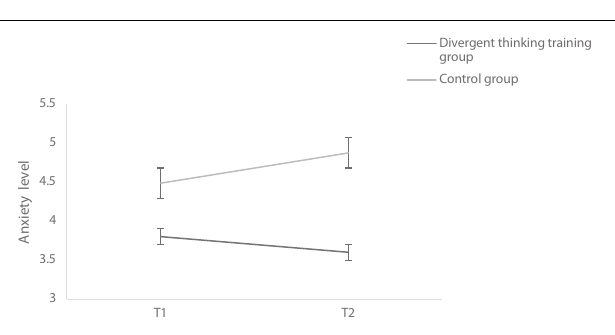
FIGURE 2 | Self-efficacy of two groups before intervention (T1) and 9 days after intervention (T2). The error line represents the standard error.